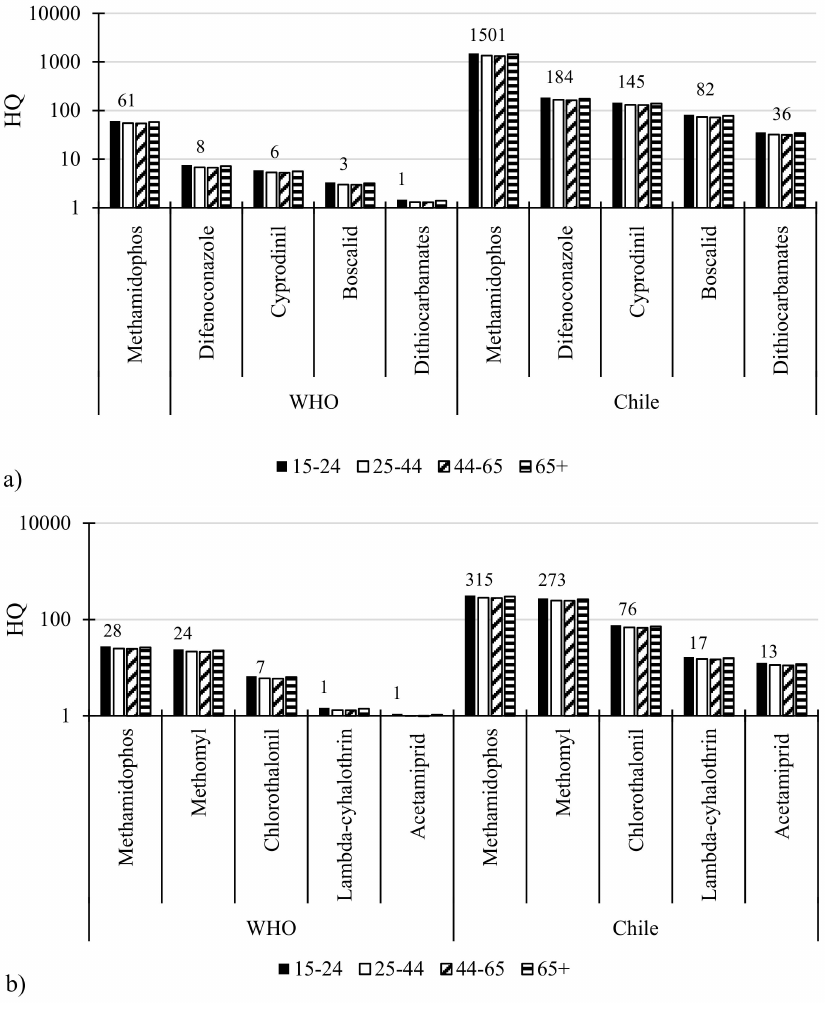
Figure 1. Hazard quotients for tomatoes and lettuces: ( a ) lettuce ( b )